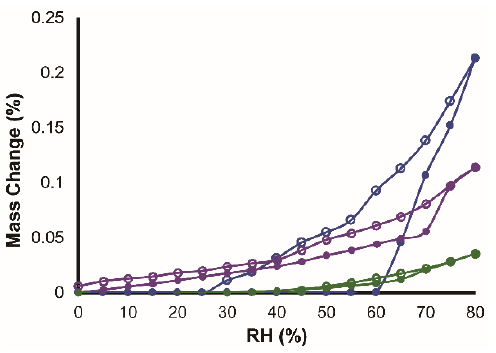
Figure 8. Water sorption–desorption of BEX–HCl (blue), BEX–SAC (purple), and BEX–CYM (green). The closed and open symbols represent sorption and desorption, respectively.